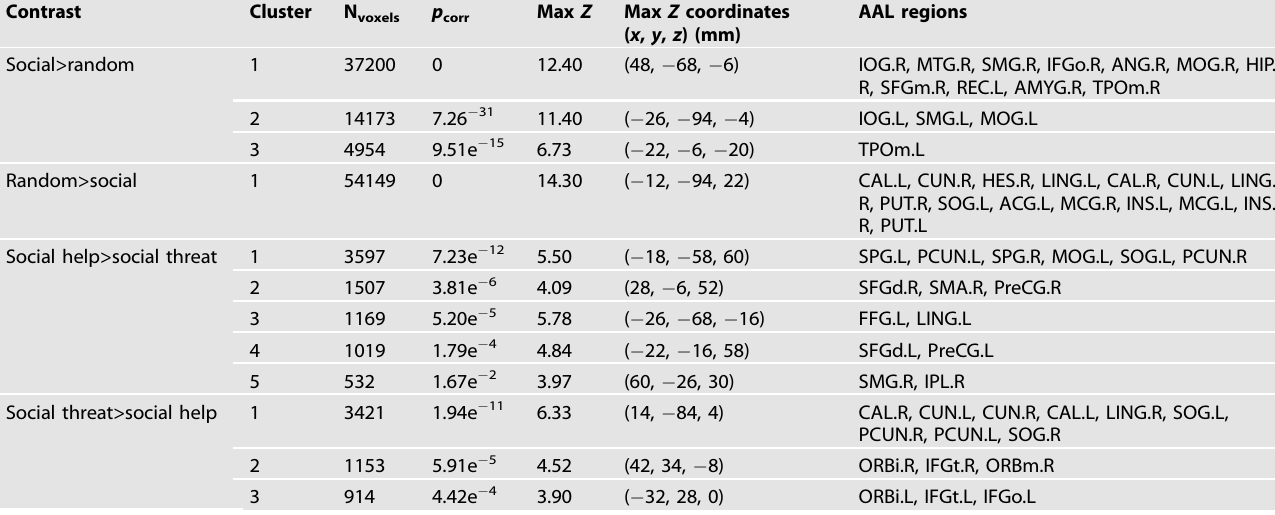
Table 3. Brain regions showing signi fi cant main effects of condition (across groups) for the social vs. random and social help vs. threat contrasts ( Z > 2.3, p corr <